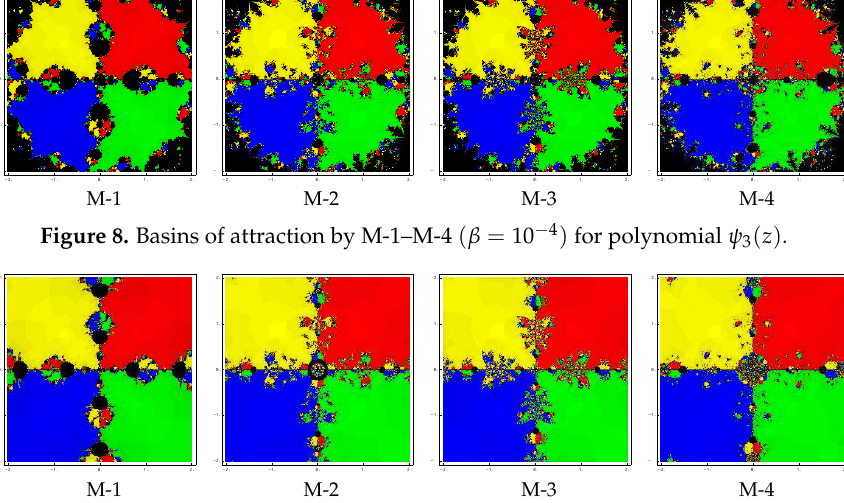
Figure 9. Basins of attraction by M-1–M-4 ( β = 10 − 6 ) for polynomial ψ 3 ( z )